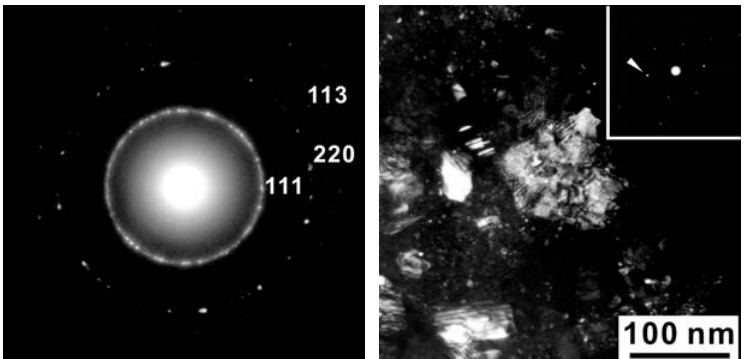
Figure 6. ( a ) Selected Area Electron Diffraction (SAED) pattern of sample Z608 in the area of the B-C-N phase; ( b ) Dark field image with g = 1 0 1 1 (cubic setting) or 1 1 1 (cubic setting) which are indicated by the arrow in the SAED (inset). Selected area electron diffraction of sample Z608 showing a nano-sized